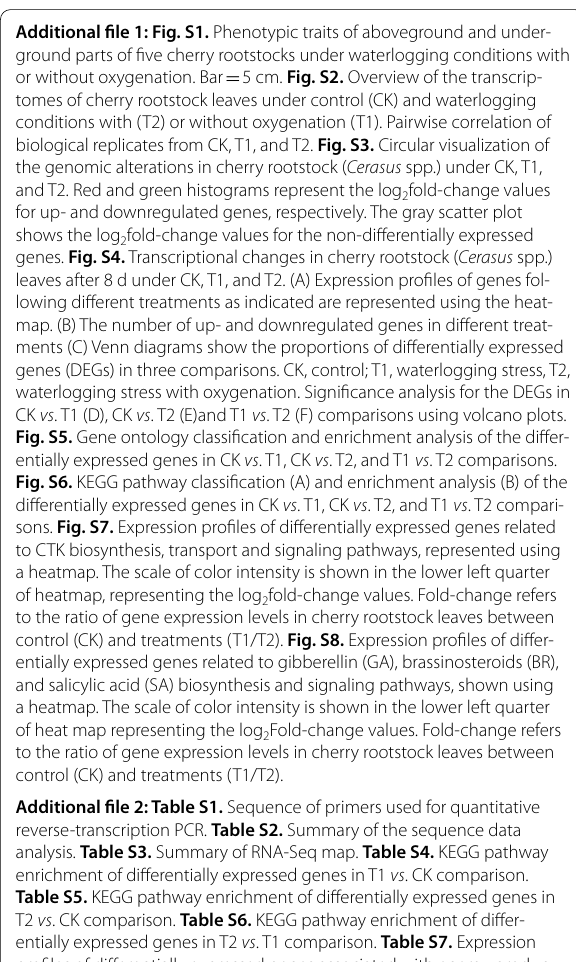
Additional file 2: Table S1. Sequence of primers used for quantitative reverse-transcription PCR. Table S2. Summary of the sequence data analysis. Table S3. Summary of RNA-Seq map. Table S4. KEGG pathway enrichment of differentially expressed genes in T1 vs . CK comparison. Table S5. KEGG pathway enrichment of differentially expressed genes in T2 vs . CK comparison. Table S6. KEGG pathway enrichment of differ-